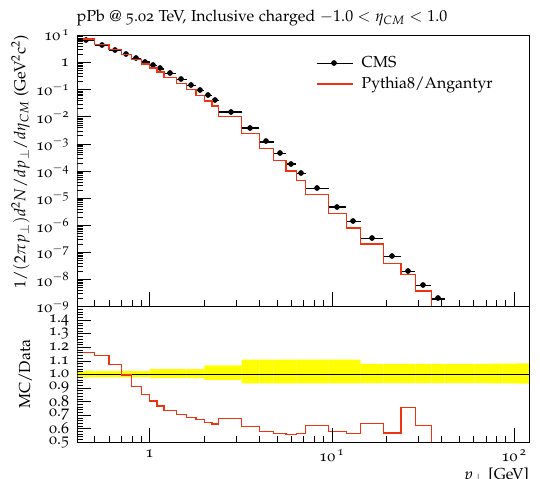
Figure 14 . The transverse momentum distribution of charged particles in the central pseudo- rapidity region in inclusive pPb events.